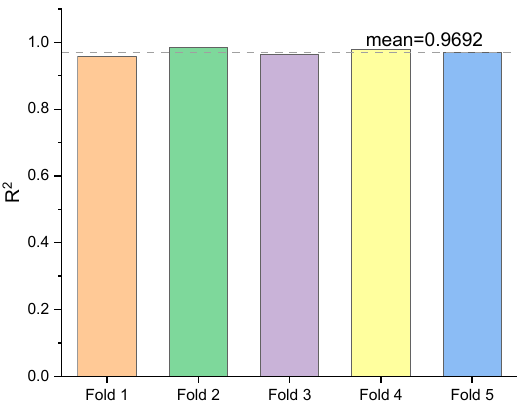
Figure 5. Results for five-fold cross validation. Table 4. Cross-validation measurement results.